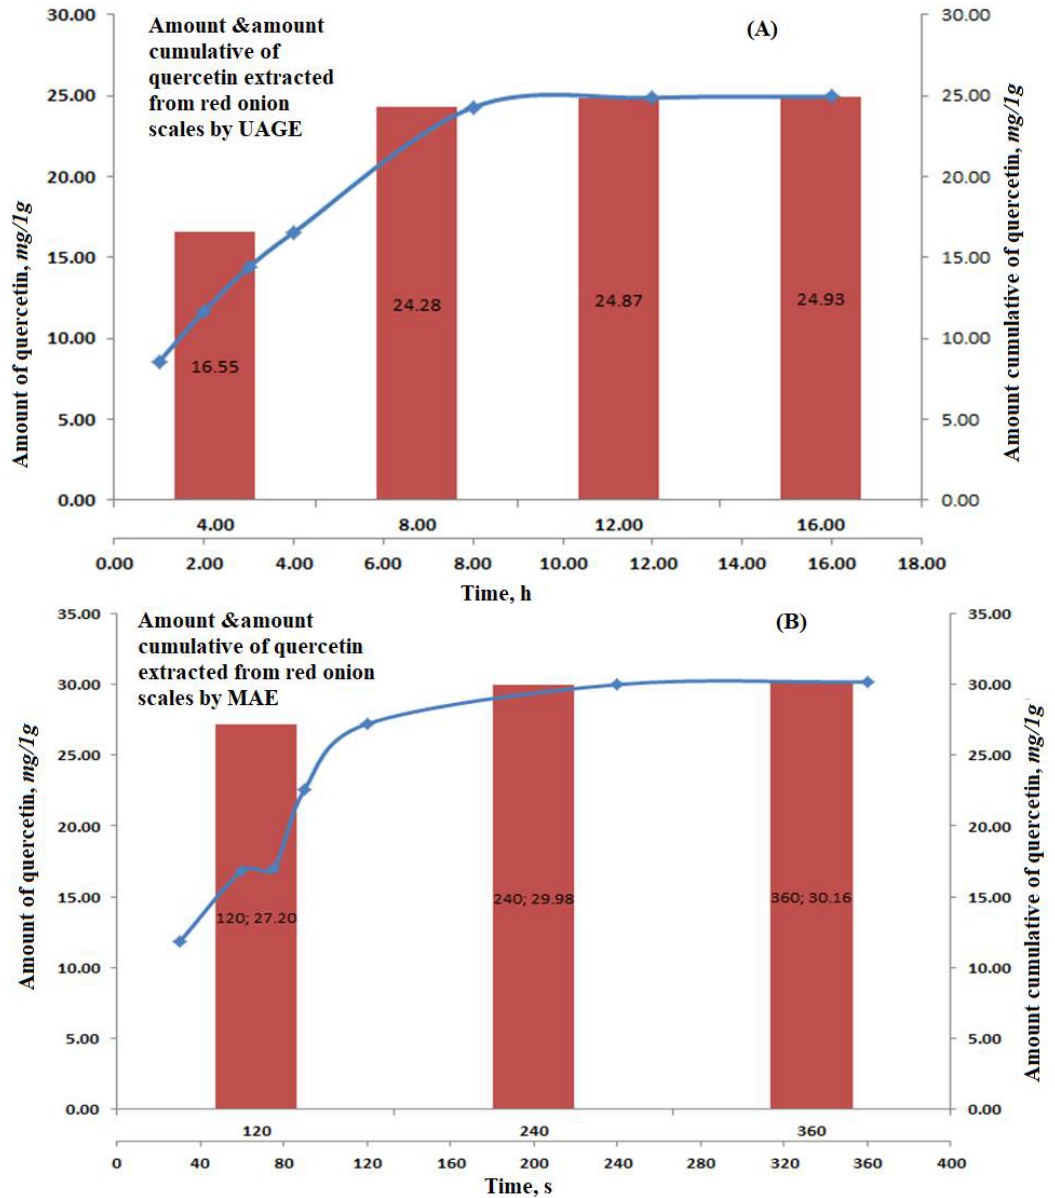
Figure 3. Graphs showing the amount of quercetin extracted and the cumulative amount of repeated cycles for: ( A ) Ultrasound-assisted glycerol extraction and ( B ) microwave aided extraction of red onion scales.